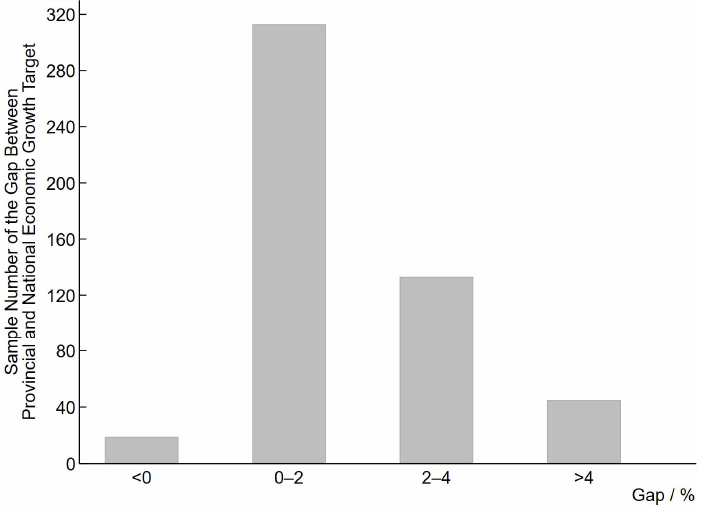
Figure 2. The gap between provincial EGT and national EGT.